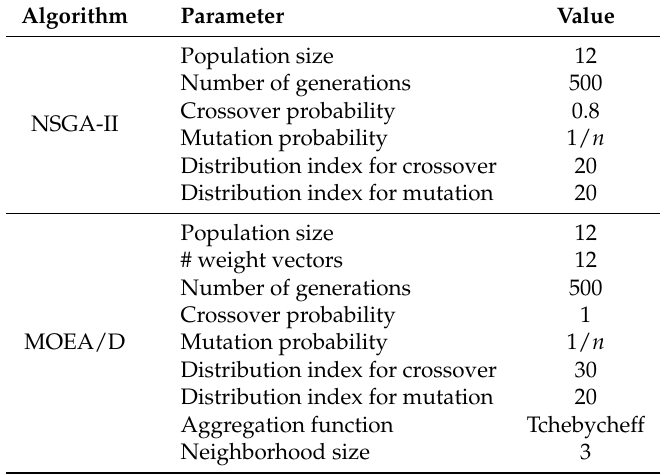
Table 6. Parameter setting for NSGA-II and MOEA/D: Here, n denotes the dimension of the decision variable space. Algorithm Parameter